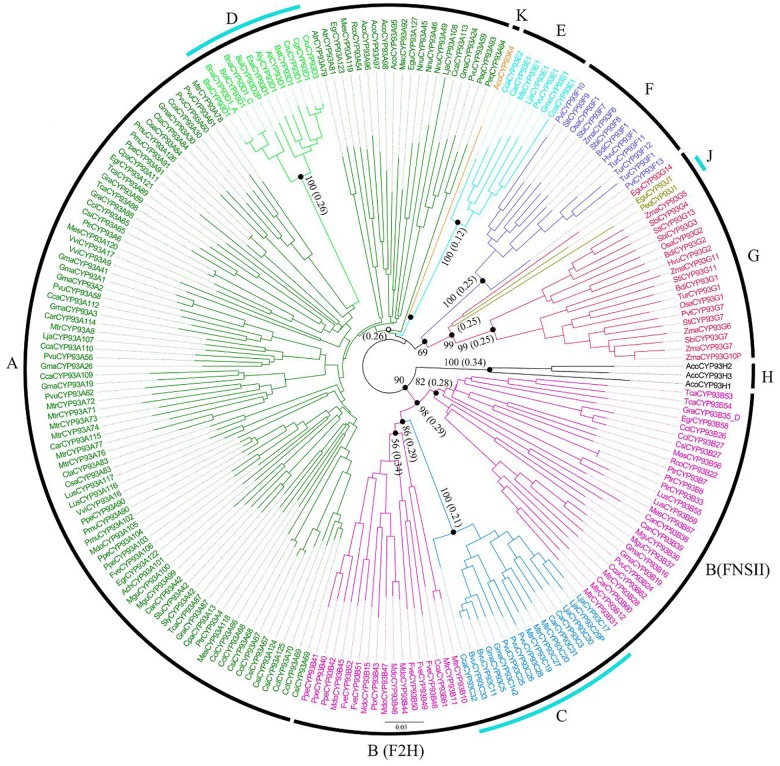
Phylogenetic tree and classification of 214 plant CYP93 proteins.The neighbor joining (NJ) tree includes 214 CYP93 proteins from 60 eukaryotes. Proteins are clustered into eight subfamilies (e.g., CYP93A). The colored lines and names symbolize the species to which the proteins in each clade belong. The black dots represent the major clades in the phylogenetic tree, and the corresponding bootstrap support values from 1000 replications are shown beside the black dots. Bootstrap values <50% are shown as black circles, and those >50% are shown as black dots in the phylogenetic tree. The numbers in brackets indicate the dN/dS value for each subfamily or branch. The information of species abbreviations used for the tree of Fig 2 is listed in S2 Table. The scale bar represents amino acid substitutions per site.